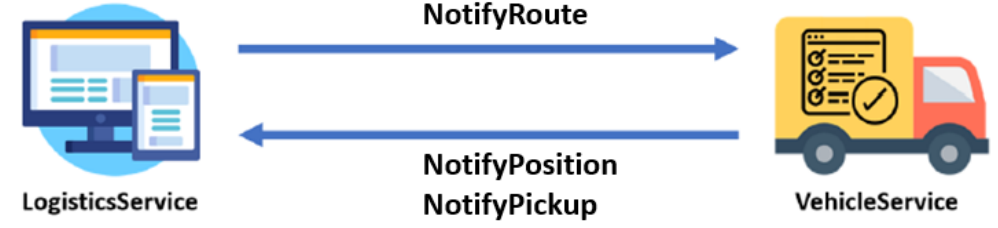
Figure 4. Initial route and recurrent